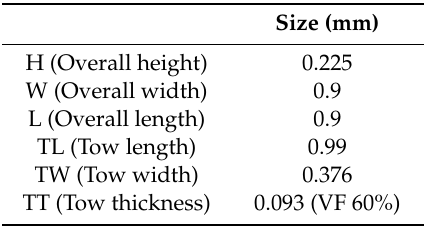
Table 6. Input data extraction for Monte Carlo Simulation of micro level.